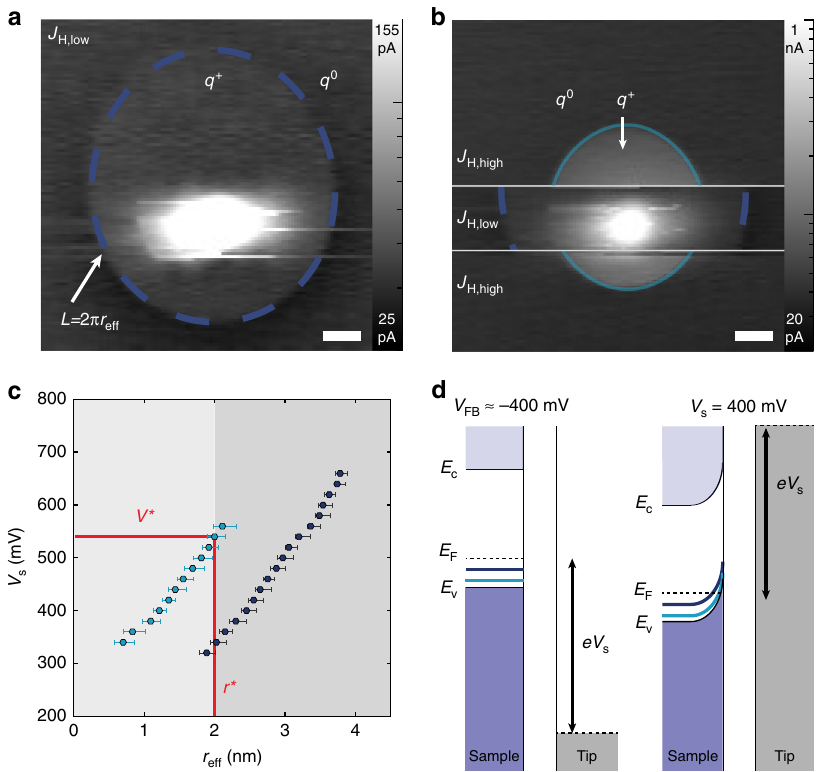
Fig. 3 Ionization of Co. a Constant-height current map of J H,low (setpoint conditions: V s = 500 mV, I t = 40 pA), showing isotropic charging state (highlighted with dashed blue ring) as a disk in the current map (logarithmic color scale, scale bar = 1 nm). Charged ( q + ) and uncharged ( q 0 ) regions are denoted. b Constant height map of same Co atom initialized into J H,high state (setpoint conditions: V s = 500 mV, I t = 40 pA, scale bar = 1 nm, logarithmic color scale). The atom switches into J H,low for a small section in the middle of the image. c Charging ring effective radius ( r eff = L /2 π ) as a function of bias for J H,low (dark blue) and J H,high (light blue). Red lines show threshold bias ( V *) determined from switching data and corresponding critical radius ( r *) for J H, J low and H,high . Error bars are derived from experimental uncertainty in the measured disk radius, further explained in Supplementary Figure 11. d Schematics of proposed fl at-band condition ( V FB ≈ − 0.4 eV) and band bending at selected bias near a ,